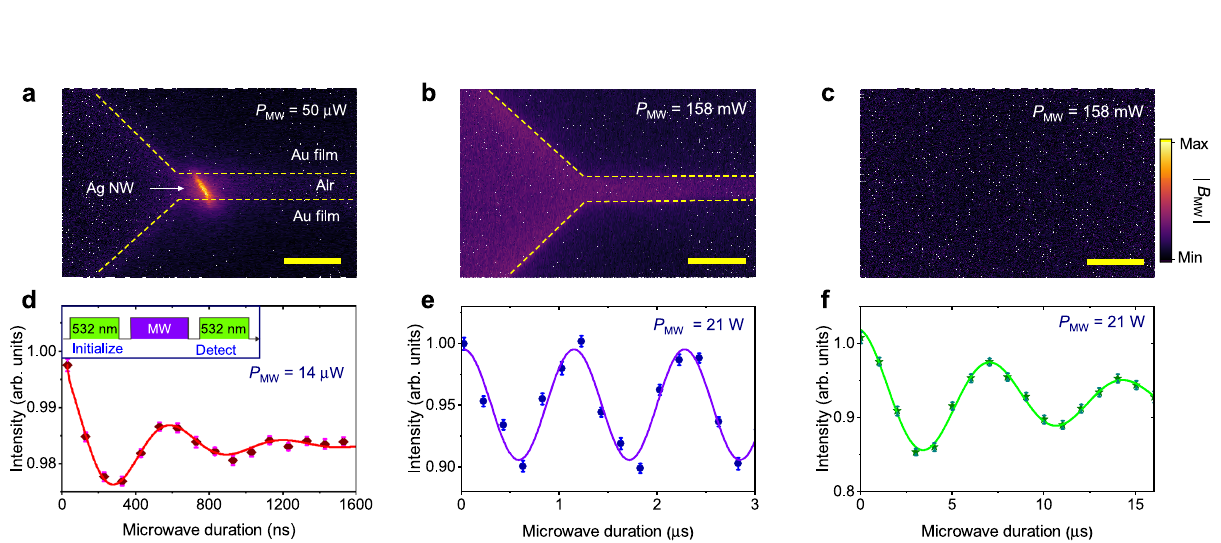
Fig. 3 Spin manipulation with the localized microwave fi eld. The wide- fi eld images of the microwave fi eld enhancement with different structures: a nanowire-bowtie antenna; b bowtie antenna without nanowire; c no structure on the diamond surface. The scale bars are 20 μ m in length. d − f Rabi oscillations of NV center with different structures in ( a − c ), respectively. The inset in d shows pulse sequences for the Rabi oscillation measurement. The Rabi oscillation in d is measured with NV center ensemble under the nanowire. And the results in e and f are measured with single NV centers. P MW is the power of the microwave source. Error bars represent the standard error.